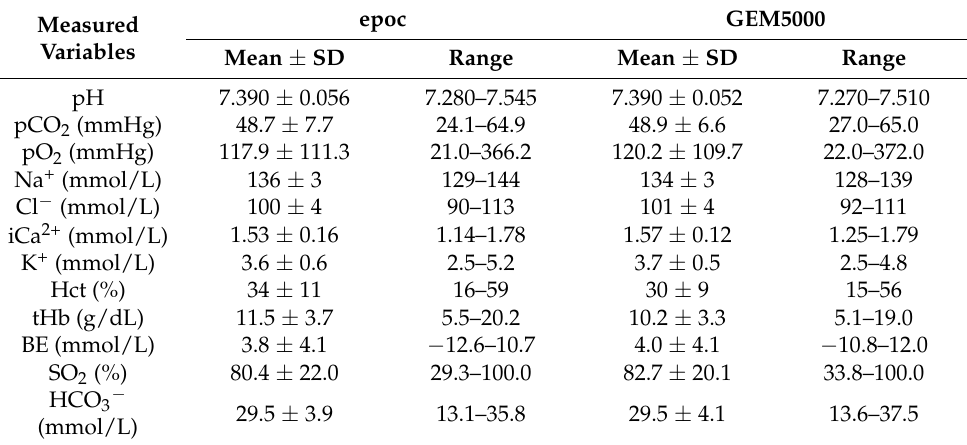
Table 2. Mean, standard deviation (SD) and measured concentration range for parameters determined by the two compared analyzers epoc and GEM5000 ( n = 43).